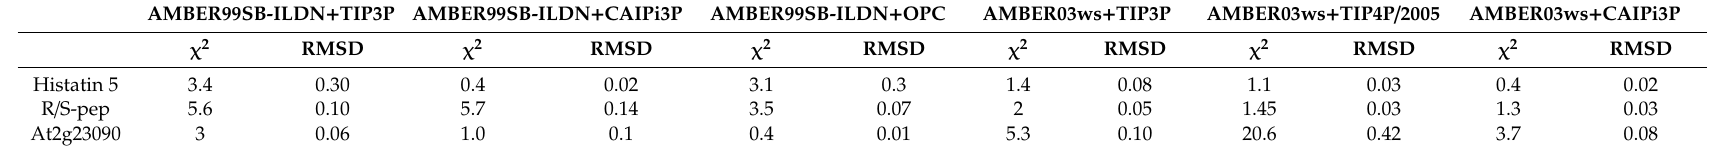
Table 3. Reduced χ 2 and RMSD metric for I / I 0 distribution for all tested